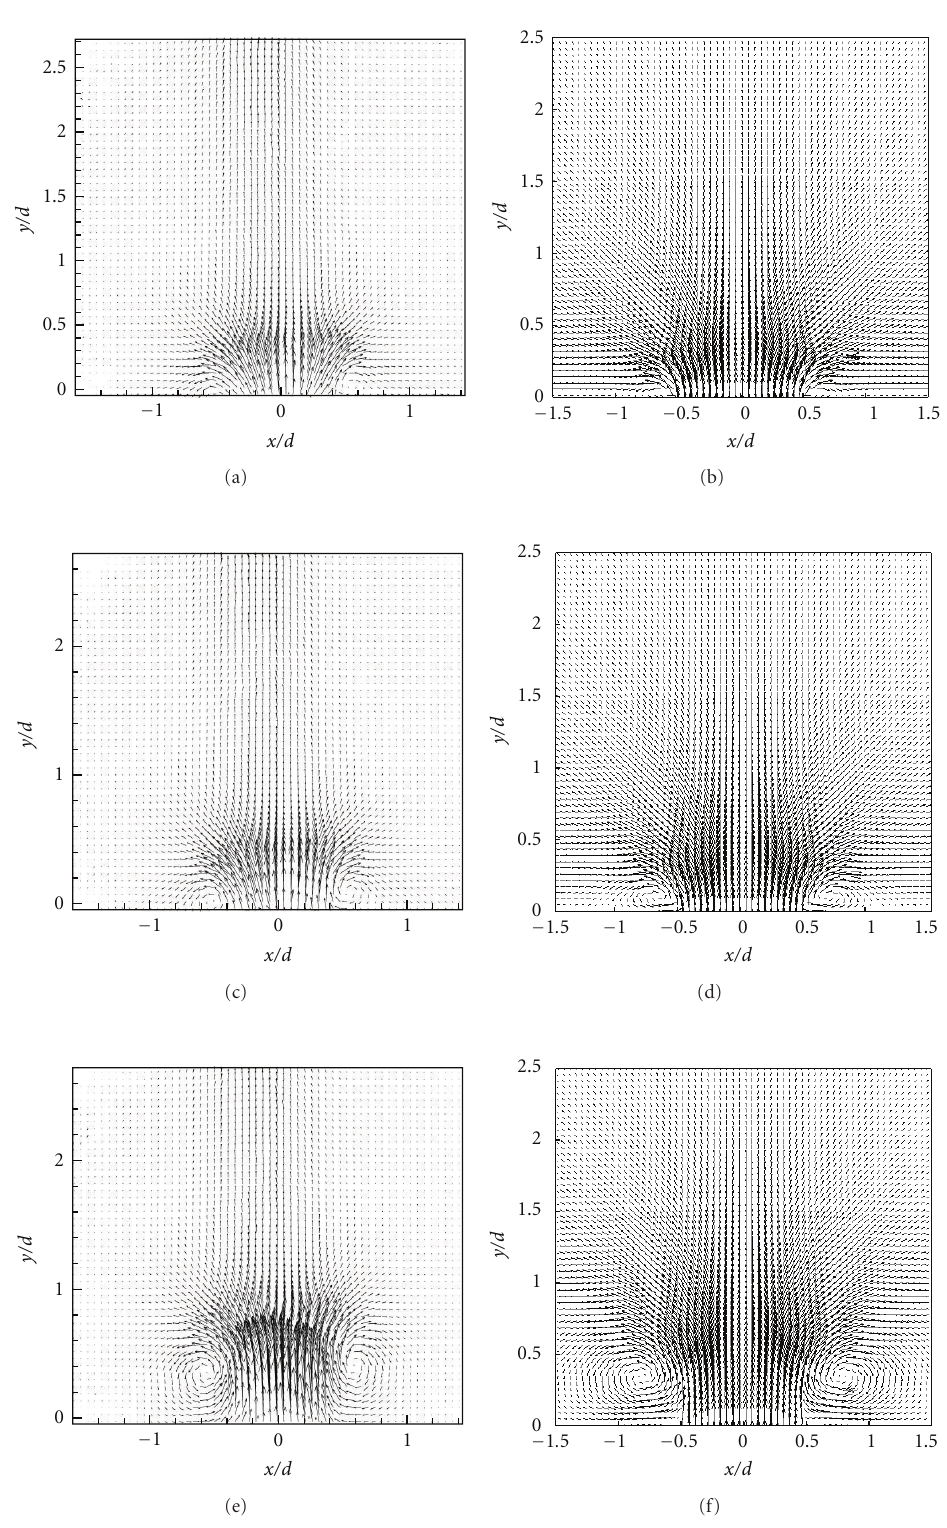
Figure 5: Comparison of experimental and numerical velocity vector plots during four phases of expulsion phase: t = 0 . 14 ((a), (b)), t = 0 . 18 ((c), (d)), and t = 0 . 26 ((e),